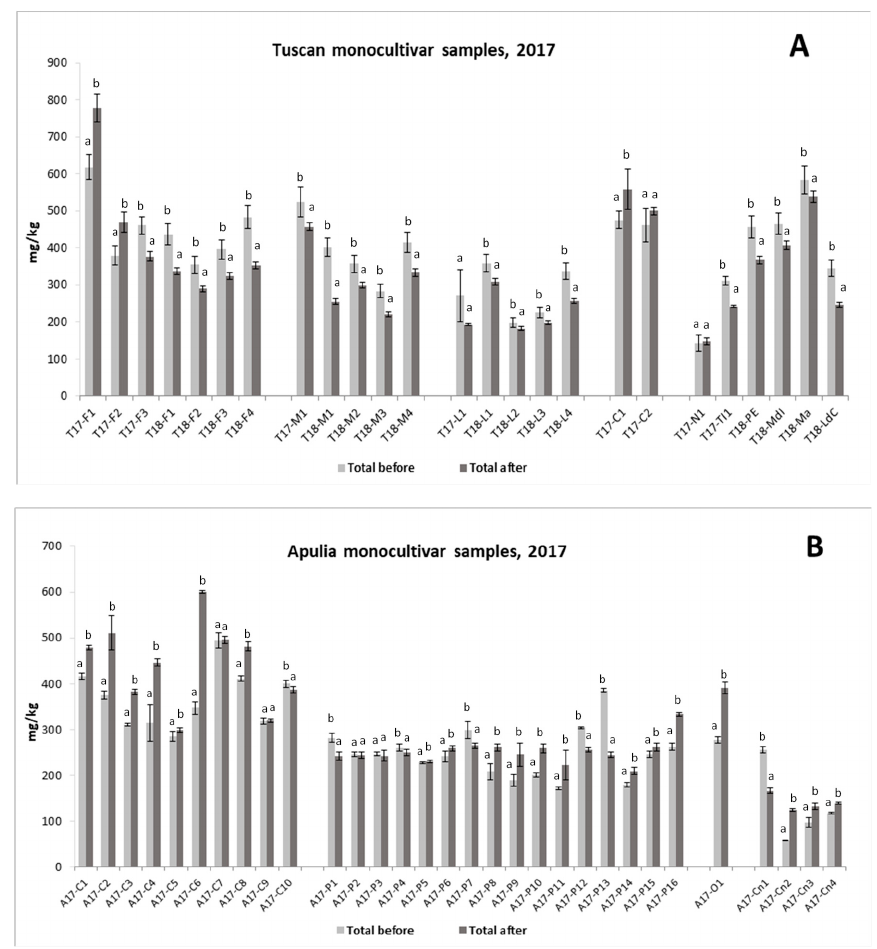
Figure 3. Total phenols evaluated by the IOC method (total before) and as a sum of OH-Tyr + Tyr calculated after the acidic hydrolysis (total after) in monocultivar samples; data are the mean of triplicates; A ) oils produced in Tuscany, B ) oils produced in Apulia in agreement with Table 3.